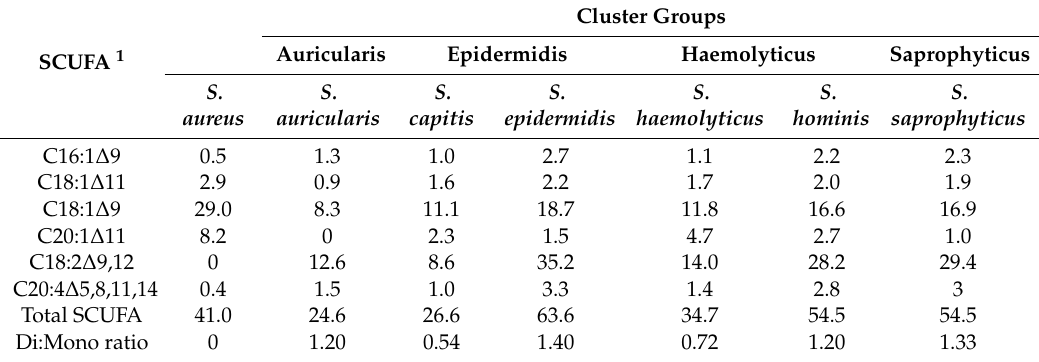
Table 4. Proportion (%) of the mono-, di-, and poly-unsaturated fatty acids in the coagulase-negative staphylococcal species grown in human